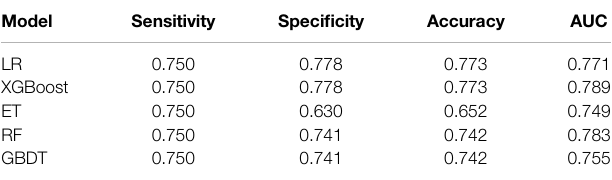
TABLE 2 | The performances comparison of fi ve models.